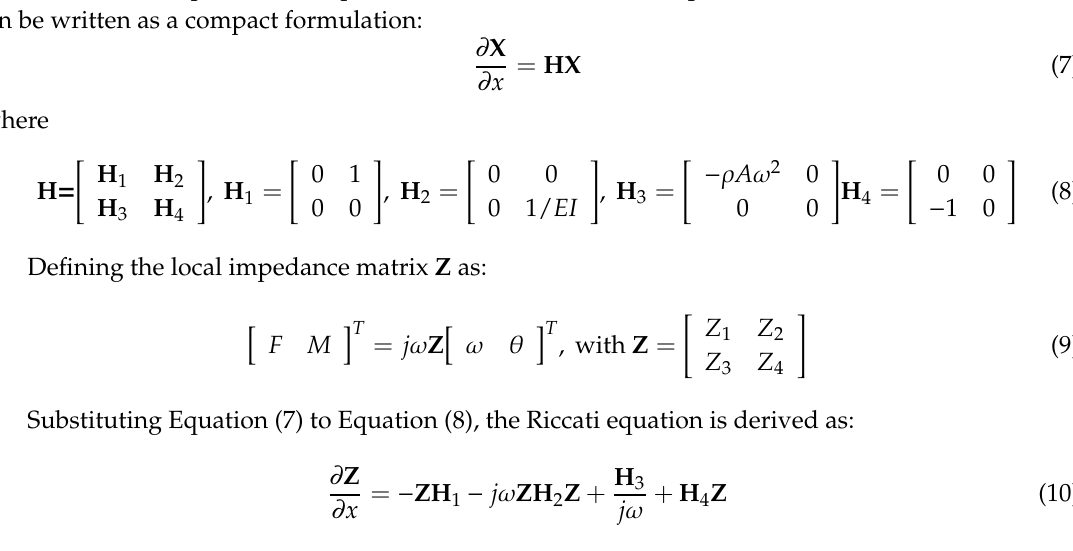
Figure 4. Real parts of the flexural wavelength along the x -axis at 8 and 20 kHz.